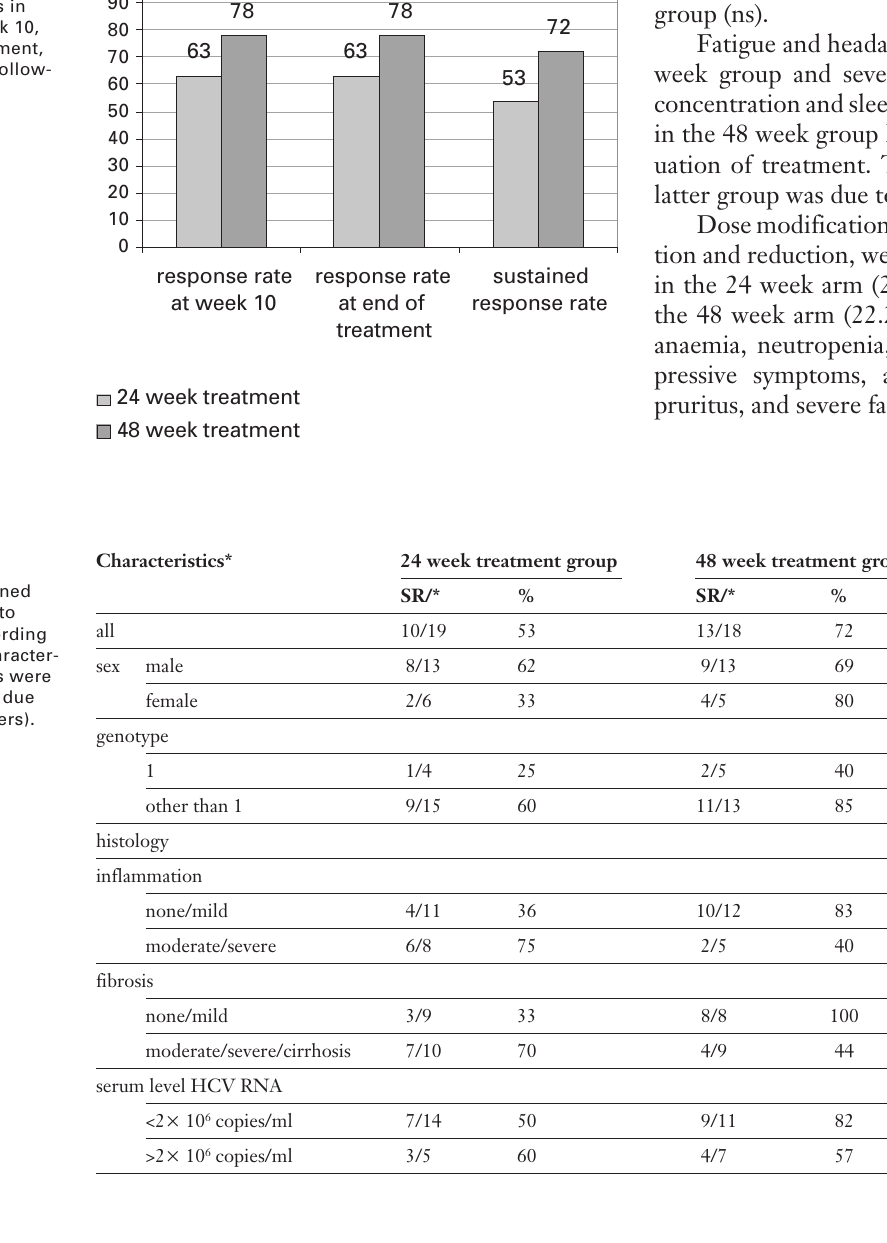
Response rates in percent at week 10, at end of treatment, and at end of follow- up (sustained response).